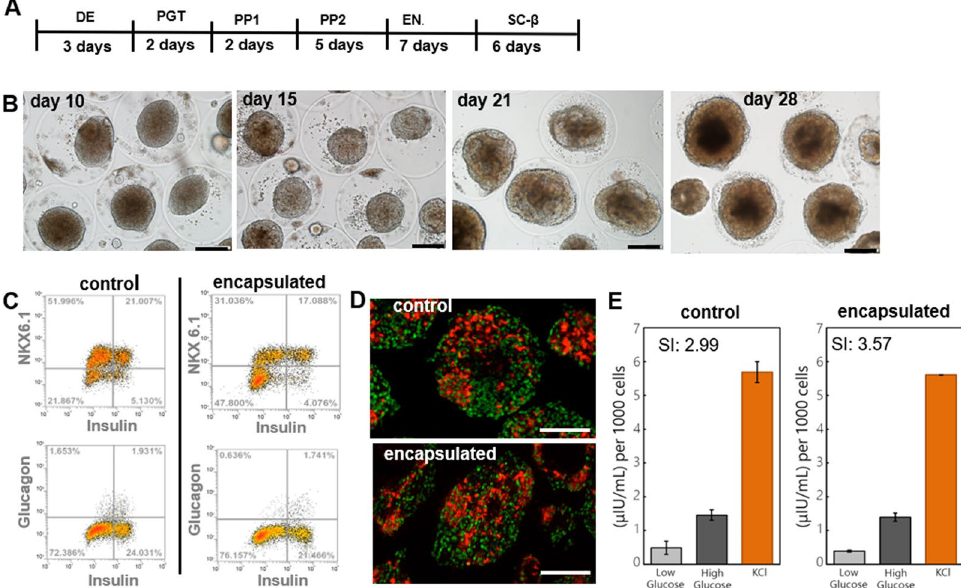
Figure 7. Differentiation of hPSC spheroids into pancreatic β-cells. ( A ) A multi-stage differentiation protocol with some of the key inductive signals at each stage. HUES-8 spheroids were differentiated in a stirred bioreactor according to this protocol. ( B ) Images of encapsulated spheroids at different time points during differentiation. Scale bar—150 μm. ( C ) Flow cytometry analysis after completion of the 4 week differentiation protocol. Cells from dissociated spheroids were labeled for endocrine pancreatic marker NKX6.1, β-cell-specific marker insulin and α-cell marker glucagon. β-cells were characterized as NKX + /insulin + /glucagon − . ( D ) Immunofluorescence staining of intact spheroids for NKX6.1 (green fluorescence) and insulin (red fluorescence). Scale bar—200 μm. ( E ) Functional analysis of β-cell spheroids using glucose stimulation insulin secretion assay. Stimulation index (SI) is the ratio of insulin produced by β-cells after high and low glucose